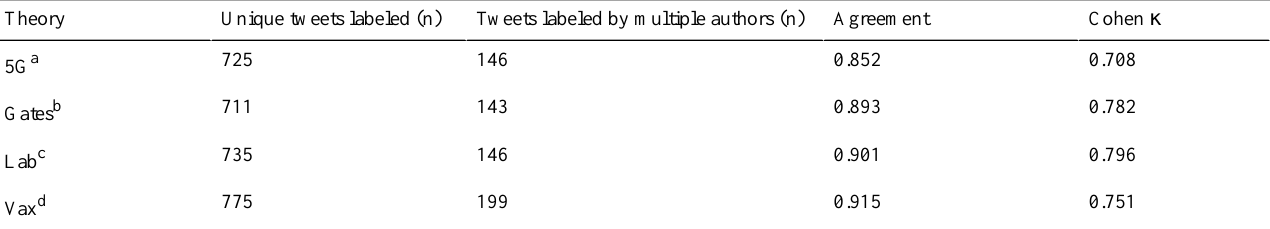
Table 1. Interrater results from the creation of the training data. Tweets were randomly sampled from the regular expression-filtered data sets and duplicates were removed. Each rater was assigned a portion of overlapping tweets to allow for interrater